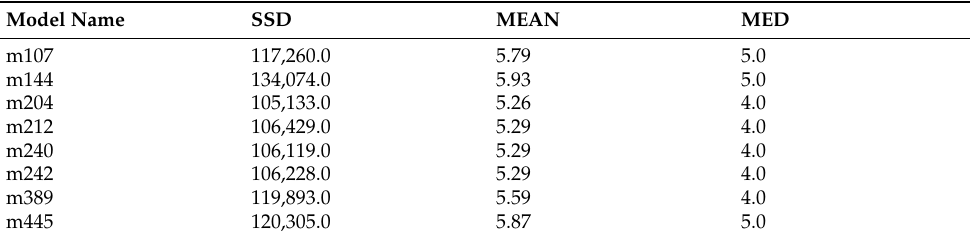
Table 4. Error estimates for ensemble models. SSD means sum of squared differences between model solution and data; MEAN and MED represent mean and median deviation of model solution from experimental data in days.